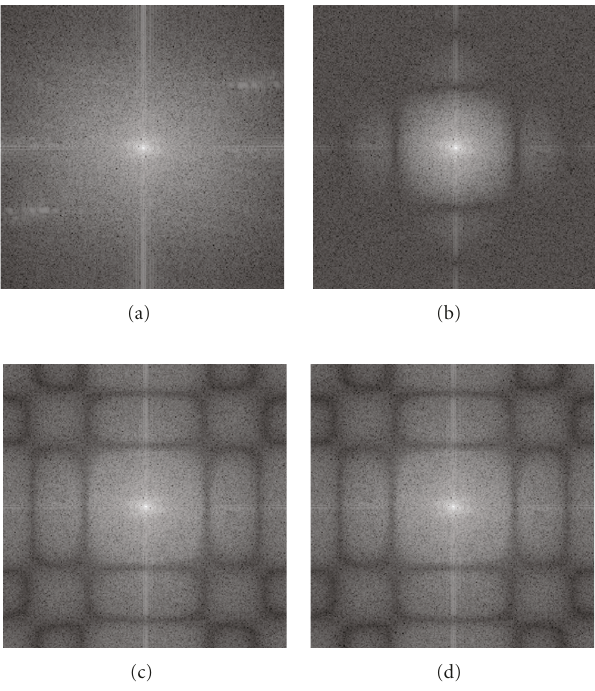
Figure 8: Spectra of images from Figure 5. All spectra are range compressed with log 10 (1 + |·| 2 ), (a) original image in Figure 5(a), (b) blurred and noisy image Figure 5(b), (c) Figure 5(c), and (d) Figure